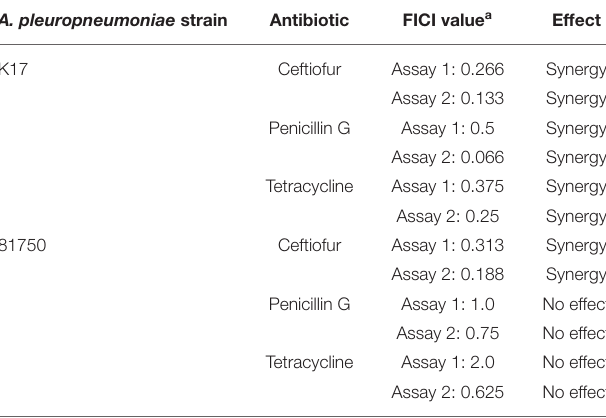
TABLE 3 | FICI values for H 2 O 2 in combination with conventional antibiotics on A. pleuropneumoniae